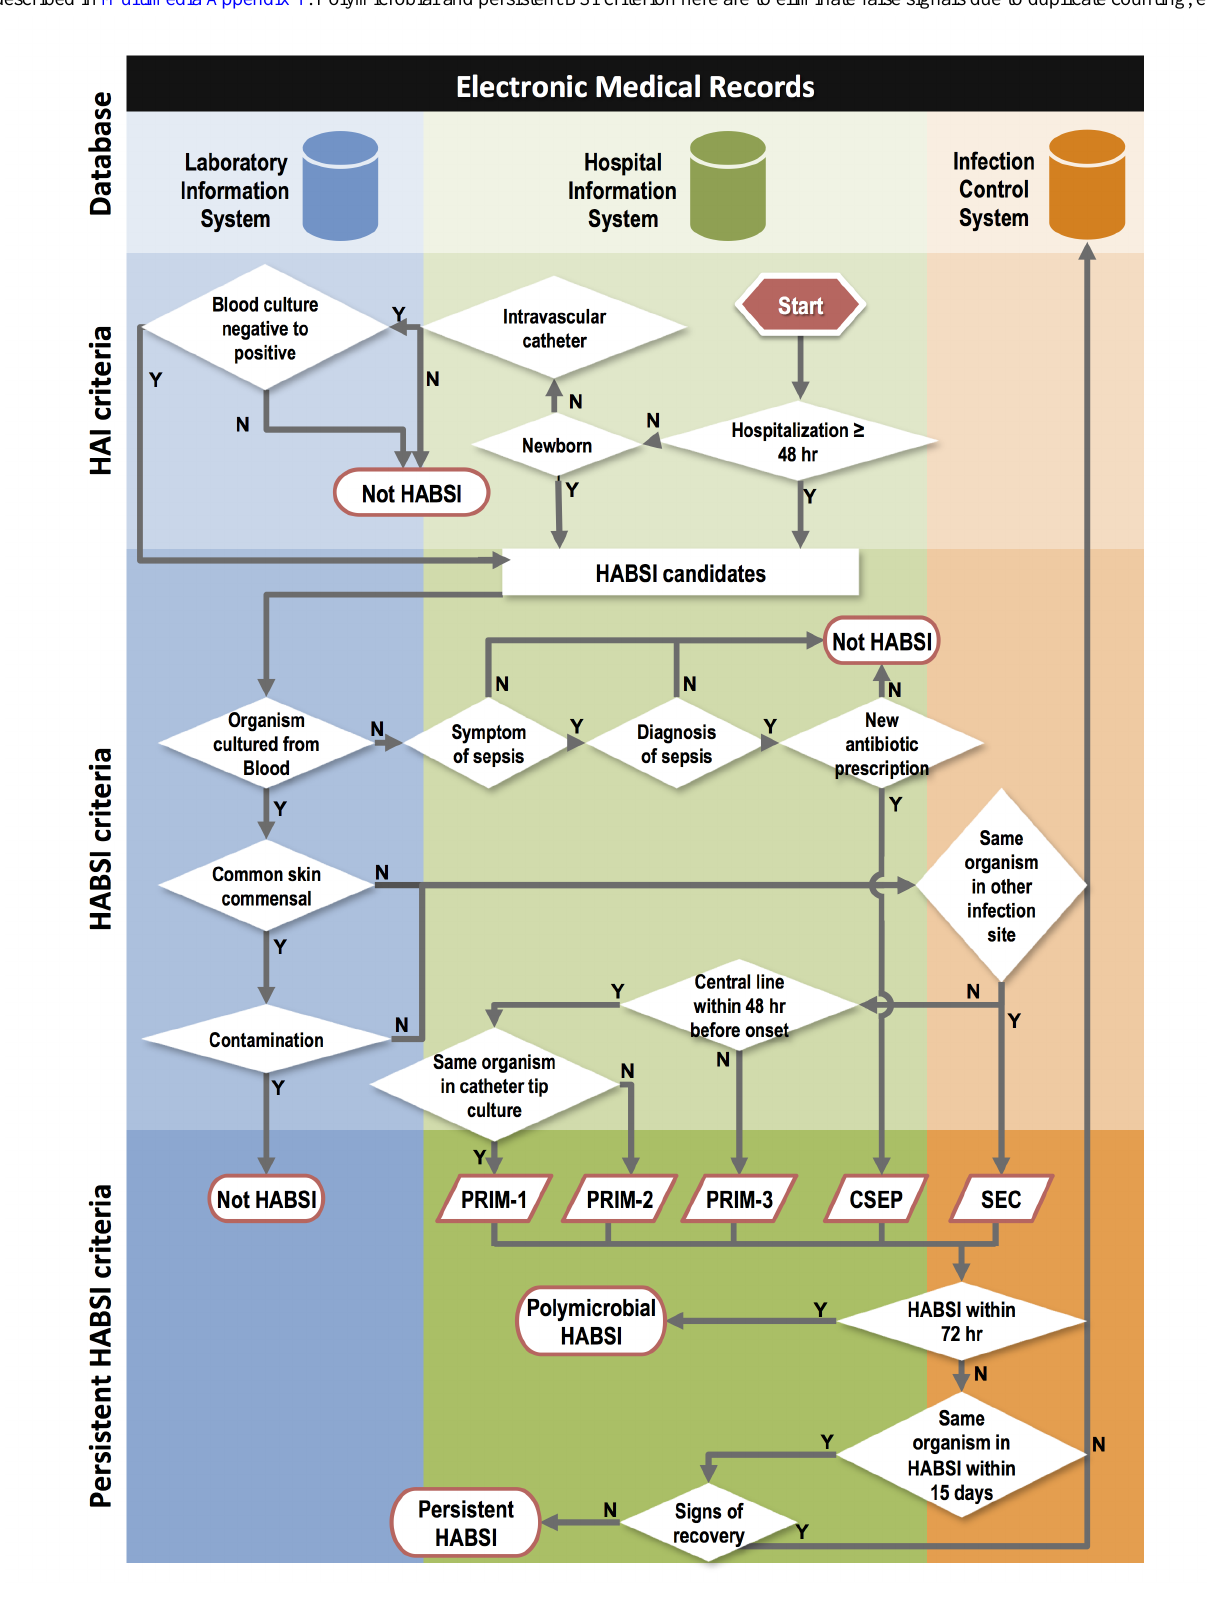
Figure 2. Computer algorithms to detect health care-associated bloodstream infection (HABSI) by active daily screening of data from hospital information system and laboratory information system. HABSIs are classified into primary HABSI (PRIM), secondary HABSI (SEC), and clinical sepsis (CSEP) as described in Multimedia Appendix 1. Polymicrobial and persistent BSI criterion here are to eliminate false signals due to duplicate counting,